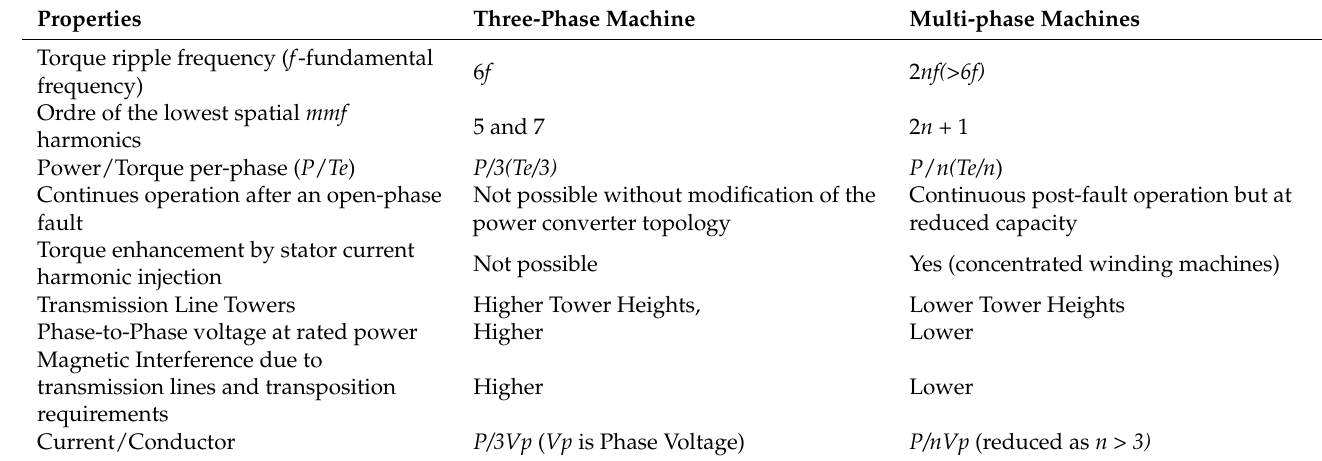
Table 1. Comparison of three-phase and seven-phase